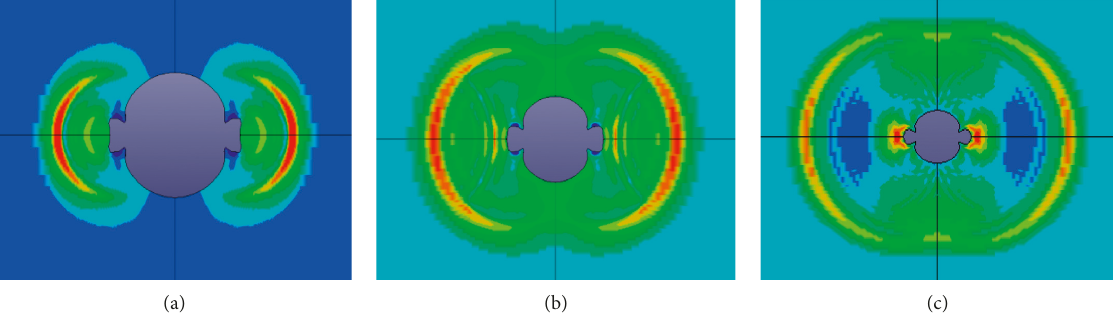
Figure 8: Propagation of stress wave under cumulative blasting with decoupling coefficient of two: (a) t � 60.96 μ s; (b) t � 86.95 μ s; (c) t � 126.98 μ s.